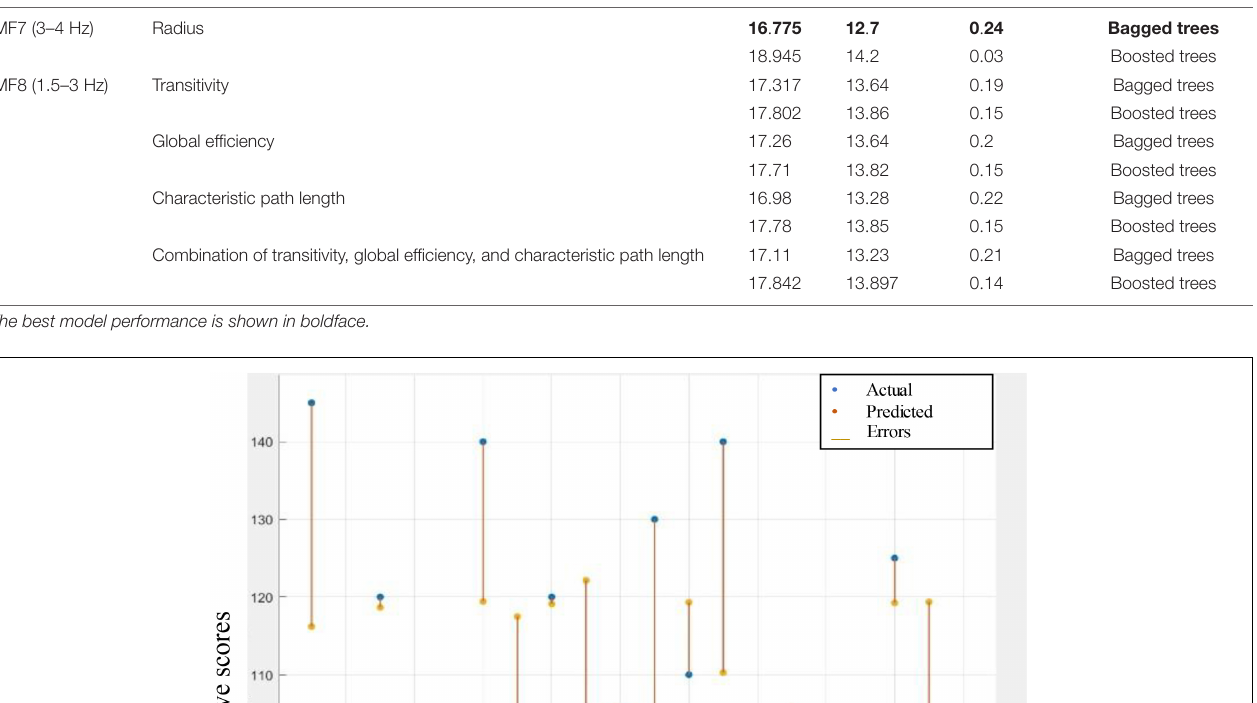
TABLE 4 | Performance of the tree ensembles regression models using the significant graph-theoretical features. Scale